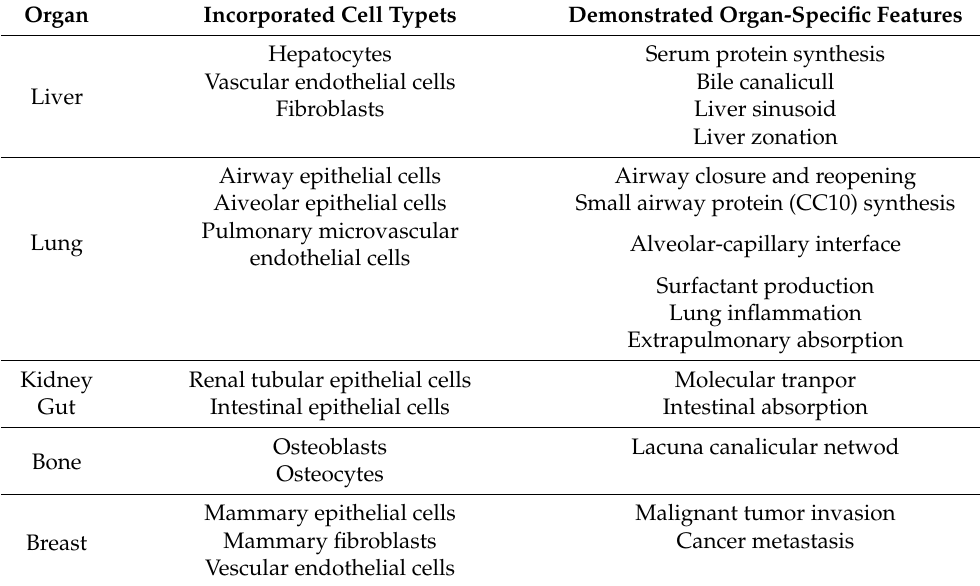
Table 1. Summary of micro-engineered organ models. The image from [51], Copyright 2011, Elsevier.